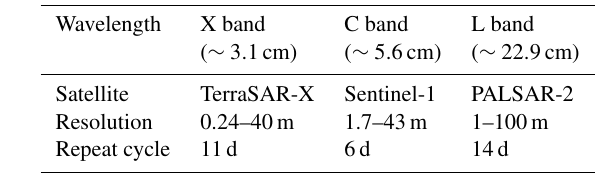
distributed scatterer interferometry (DSI) (Berardino et al., 2002; Ferretti et al., 2011; Lanari et al., 2007) approaches are used and adapted. These two approaches estimate sur- face movement across a broad area at millimeter accuracy.